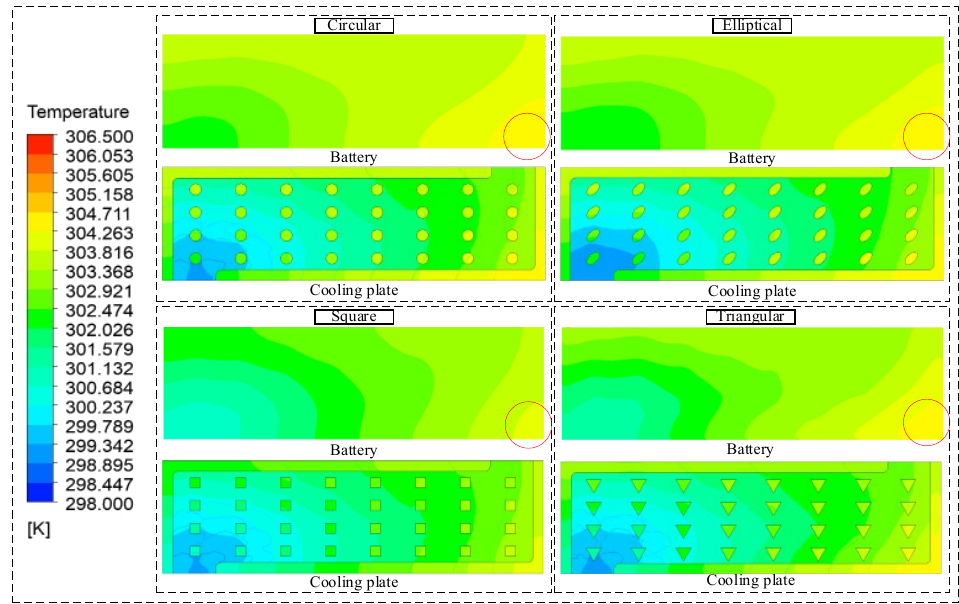
Figure 8. Temperature contour of battery and cooling plate with four shapes pin-fins.